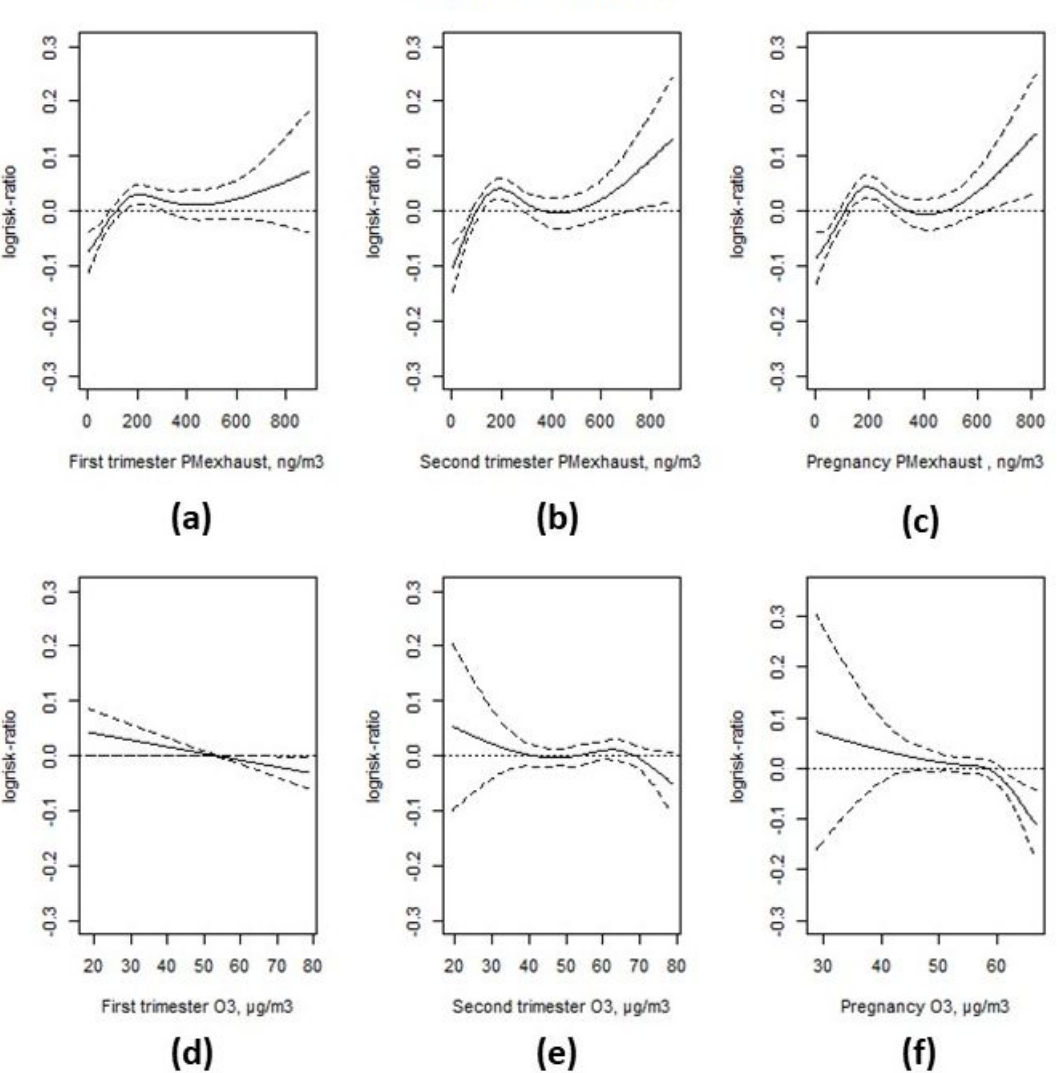
Figure A3. Unadjusted associations between exhaust PM-exhaust ( a – c ) and ozone (O 3 ) ( d – f ) during Figure B1. Unadjusted associations between exhaust PM-exhaust (a–c) and ozone (O 3 ) (d–f) during di ff erent stages of gestation and different stages of gestation and SGA.